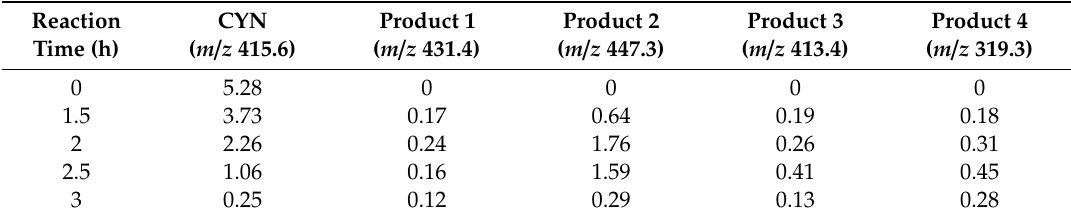
Table 1. Intensity of LC / MS peak area (count × 10 5 ) for intermediates produced during CYN degradation by pyrite a